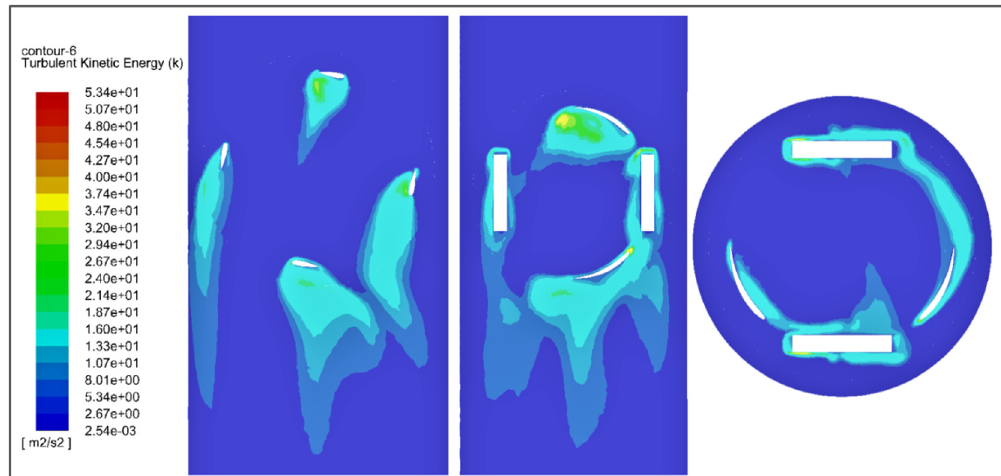
Figure 19. Turbulent kinetic energy contour showing the variation in turbulent kinetic energy along the mesh.